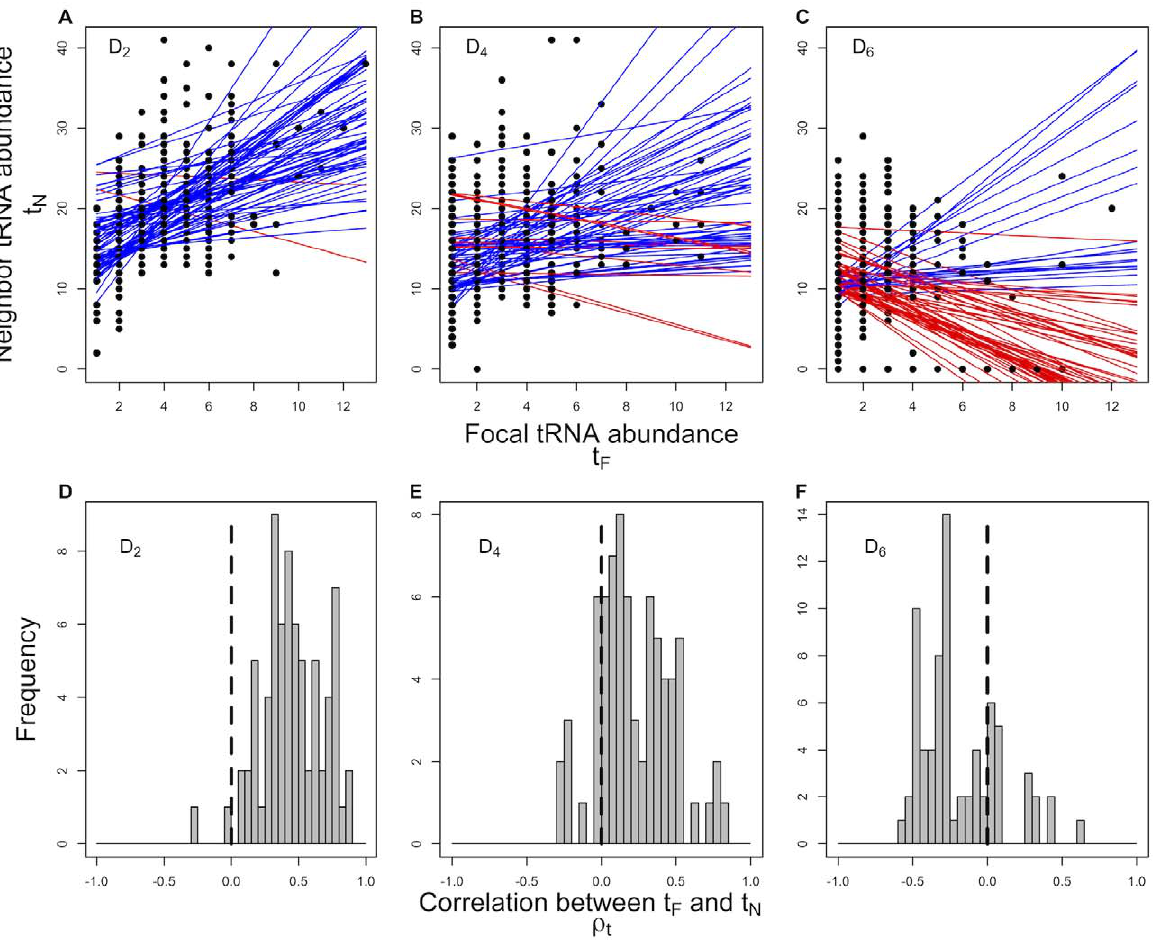
Figure 1. Correlation between a focal tRNA’s abundance t F and the abundance of its neighbors t N , r t across 73 prokaryotic genomes. Each point in panels (A–C) represents a tRNA species that encodes an amino acid with degeneracy D i ( i ~ f 2, 4, 6 g ) . The solid lines represent the regression lines between t F and t N for each genome. Genomes with a negative r t are coded in red, while genomes with a positive r t are represented by blue lines. Panels (D–F) present the distribution of correlation coefficients r t between t F and t N across all the genomes. The mean of the distribution of r t values for all the three degenerate classes differ significantly from 0 (Wilcox test, p v 10 { 7 ).